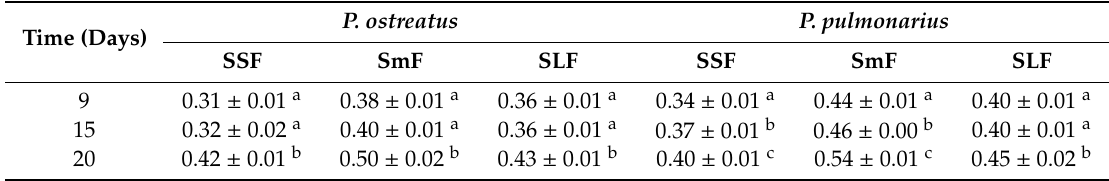
Table 2. Biomass production (g / g of dry substrate) during solid-state (SSF), submerged (SmF) and semiliquid (SLF) fermentations of P. ostreatus and P. pulmonarius using grape pomace as substrate. P. ostreatus P. pulmonarius